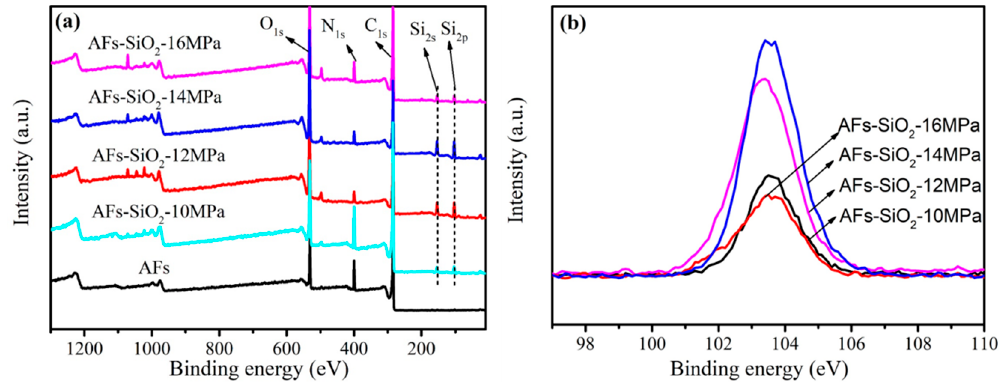
Figure 5. XPS wide scan of the untreated and SiO 2 -modified AFs ( a ); Si 2p core-level spectra of SiO 2 -modified AFs ( b ). Table 1. Surface elements of AFs before and after treatment with nano-SiO 2 . Sample Atomic Percent (%)